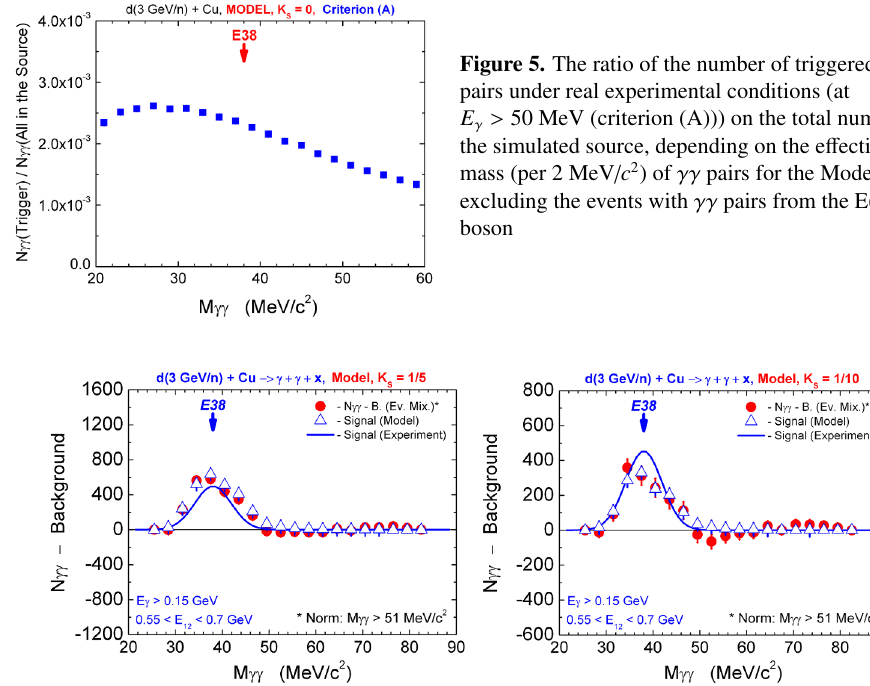
Figure 6. Invariant mass distributions (per 3 MeV / c 2 ) of γγ pairs from the decay of E(38) under the real experimental conditions: (cid:52) - pairs γγ , selected by means of labels of photons applied in the model; • - the result of processing the simulated data with the method applied to the experimental data. The curves are the experimental signal after the background subtraction (Gaussian approximation) proportional to the number of d + Cu events containing a pair of γγ in the required energy range. The signal in the simulated data reduced by a factor K S = 1 / 5 (among the events, containing a photon from the decay of E(38), each 5th event was taken) (left figure) and by a factor K S = 1 / 10 (right